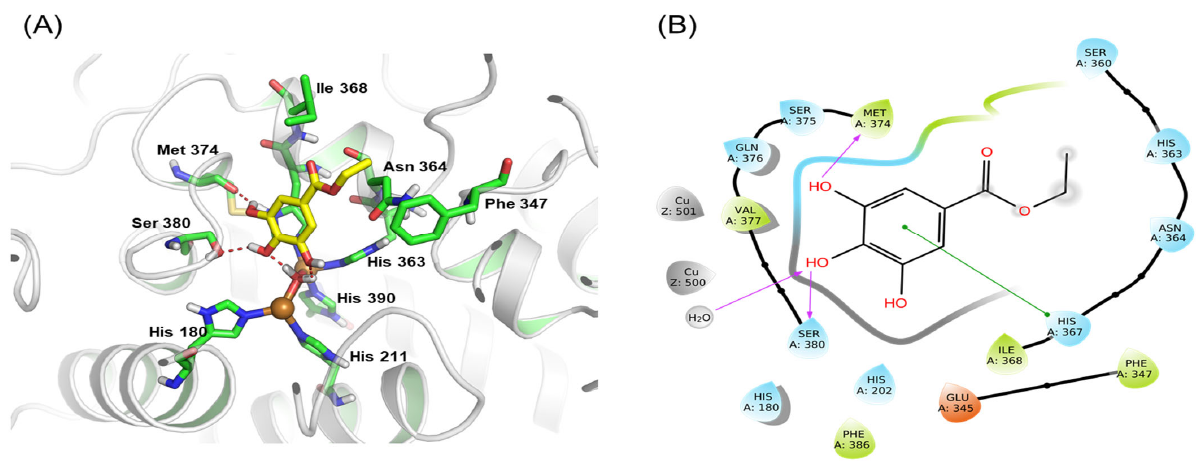
Figure 7. ( A ) Binding model prediction of human tyrosinase and ethyl gallate. The red dashed line denotes the hydrogen bond interaction. ( B ) Ligand interaction diagram of human tyrosinase and ethyl gallate. The purple arrows denote hydrogen bond interactions, and the green color denotes pi–pi interactions of human tyrosinase and ethyl gallate.